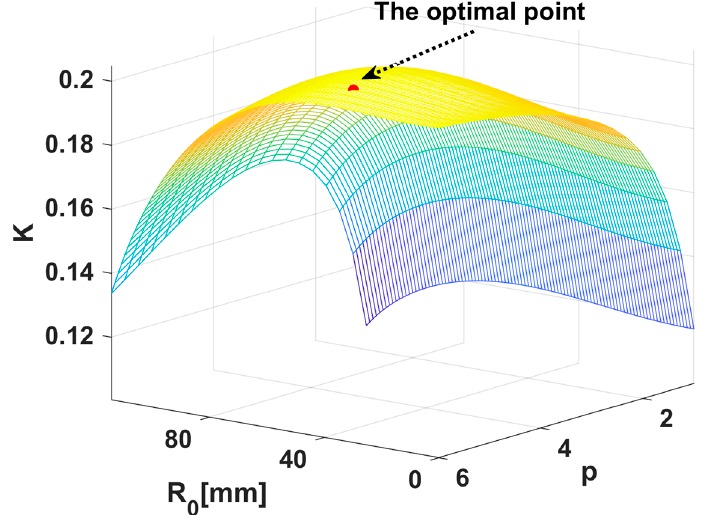
Figure 5. A 3D searching space plot of the coupling coefficient ( K ) as a function of the inner radius ( R ) and quasi-elliptical parameter ( p ). The optimal point of the coupling coefficient ( K ) is indicated by an arrow.